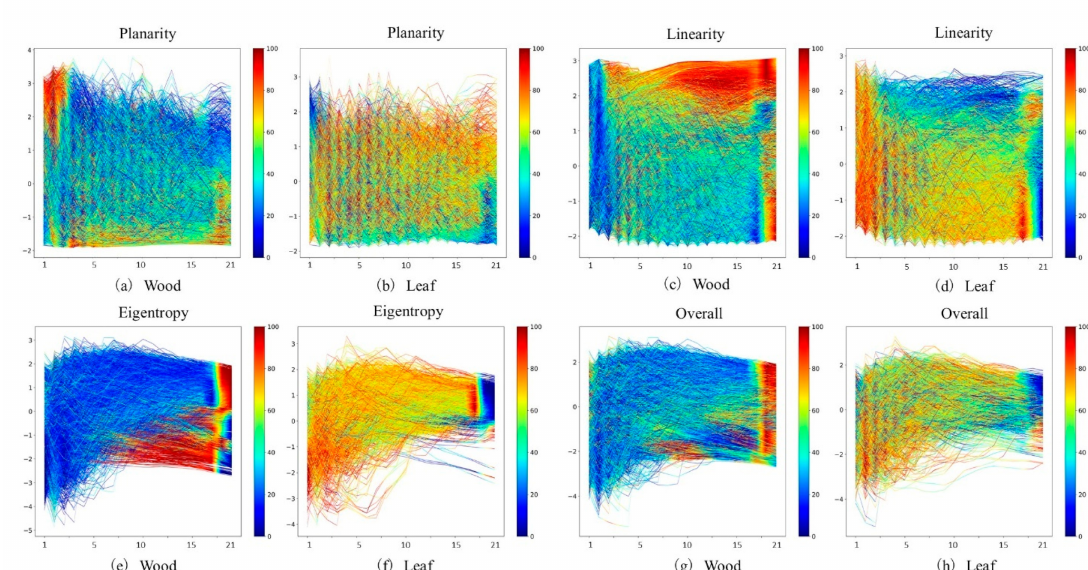
Figure 4. Class Activation Map (CAM) of univariable (UTS) and multivariable time series (MTS) using fully convolutional networks (FCN) on the validation data; ( a ) CAM of Planarity on Wood, ( b ) CAM of Planarity on Leaf, ( c ) CAM of Linearity on Wood, ( d ) CAM of Linearity on Leaf, ( e ) CAM of Eigentropy on Wood, ( f ) CAM of Eigentropy on Leaf, ( g ) CAM of Overall on Wood, ( h ) CAM of Overall on Leaf.